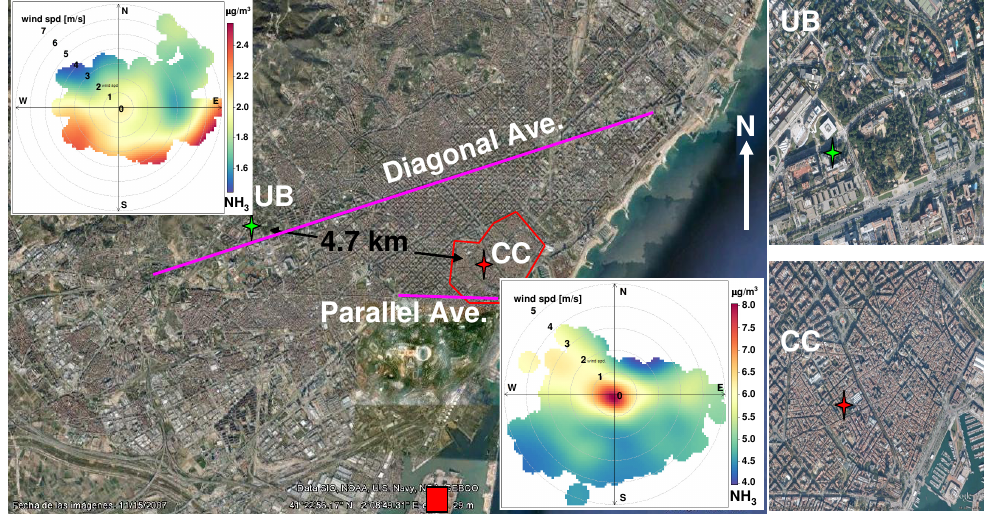
Fig. 4. Polar plots of the concentrations of NH 3 measured at UB and CC sites. Table 2. Coefficients of determination ( R 2 ) at UB measurement site. R 2 higher than 0.6 are highlighted in